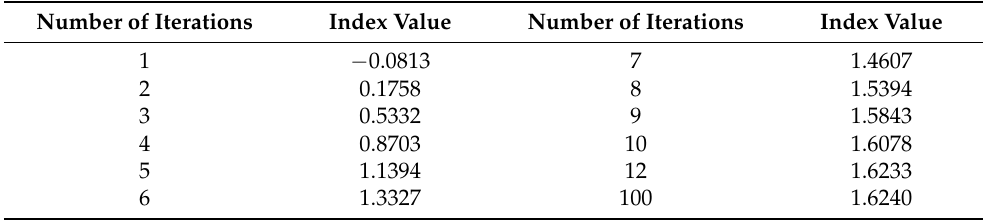
Table 2. Convergence of the iterative process for Photo Number 2.